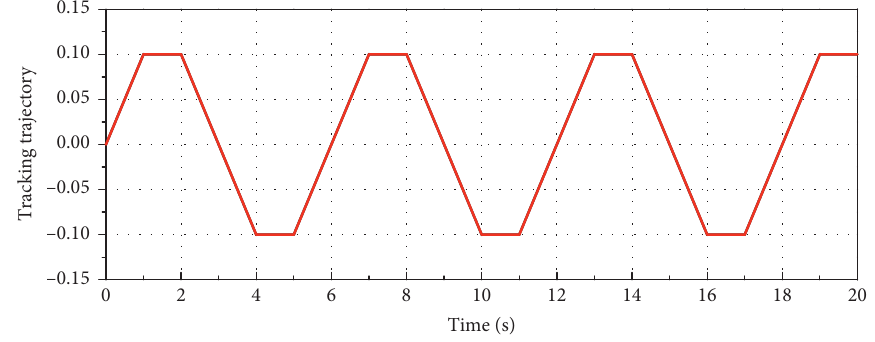
Figure 15: Desired trajectory in test 2.